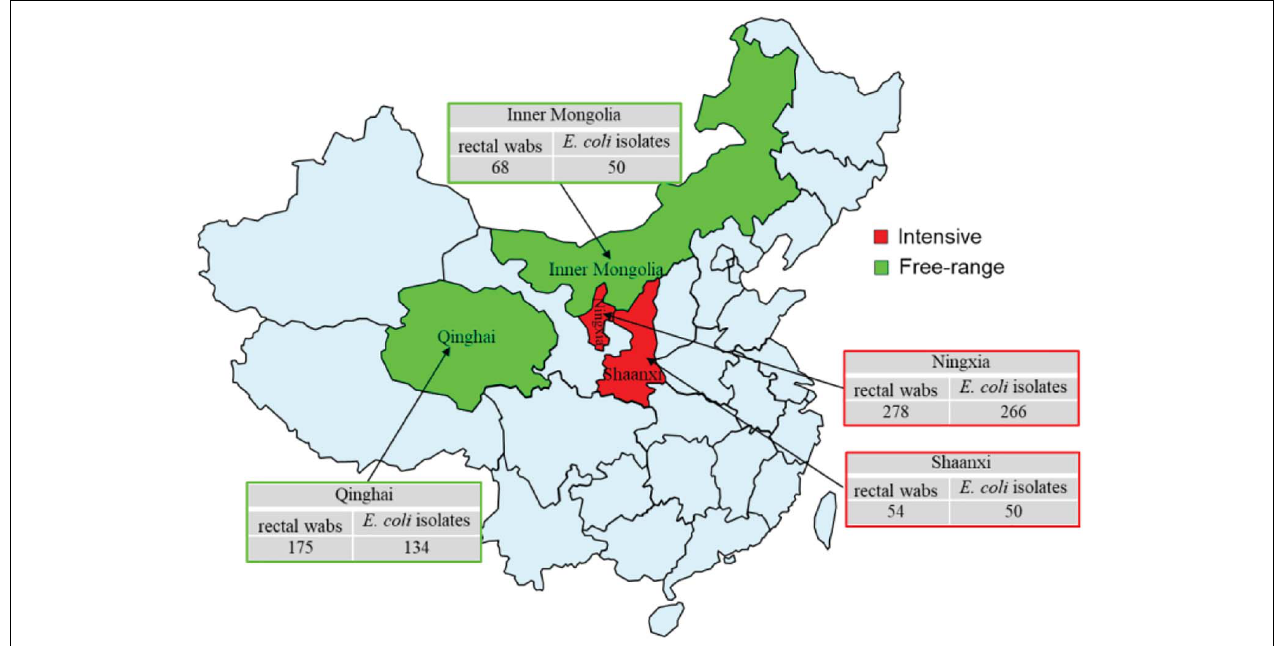
FIGURE 1 | Sample collection regions in China during 2019–2020. The rectal swabs were collected from intensive farming wool sheep with diarrhea, Ningxia (East longitude 103 ◦ 40 (cid:48) , Northerly latitudes 36 ◦ 03 (cid:48) ), Shaanxi (East longitude 109 ◦ 49 (cid:48) , Northerly latitudes 34 ◦ 45 (cid:48) ), free-range wool sheep with diarrhea, Qinghai (East longitude 101 ◦ 77 (cid:48) , Northerly latitudes 36 ◦ 62 (cid:48) ), and Inner Mongolia (East longitude 109 ◦ 99 (cid:48) , Northerly latitudes 39 ◦ 82 (cid:48) ). Red and green colors indicate intensive and free-range farming,